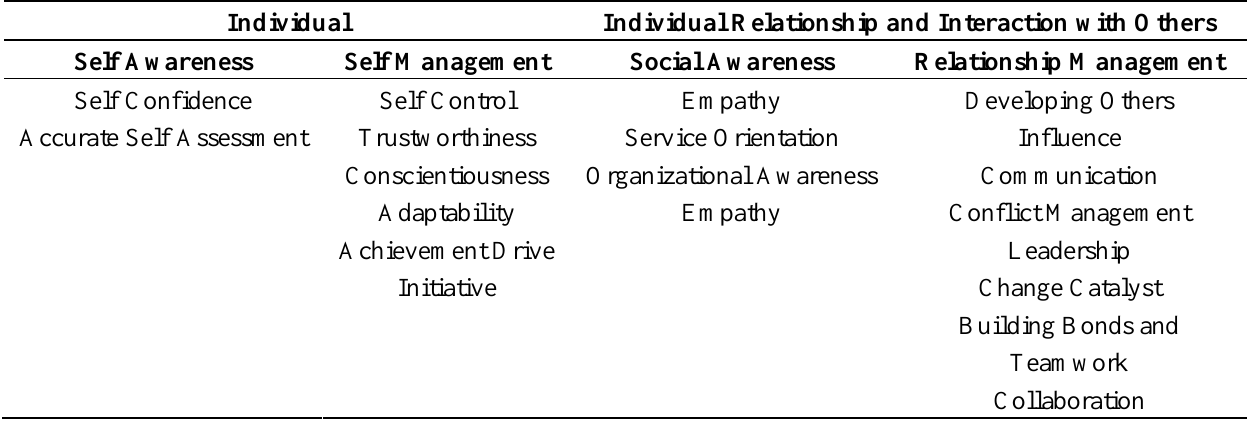
Table 1. Dimensions of emotional intelligence and associated behavioral competencies